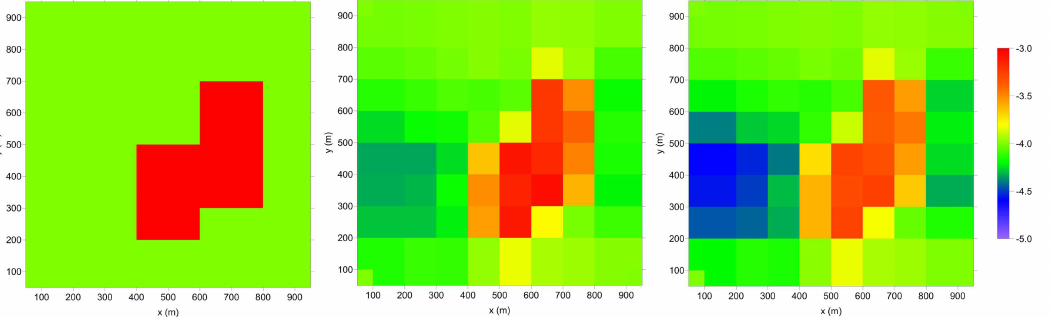
Figure 7. Simple test of the comparison model method (CMM): hydraulic conductivity field; the K , with K expressed in ms − 1 . color scale refers to log 10